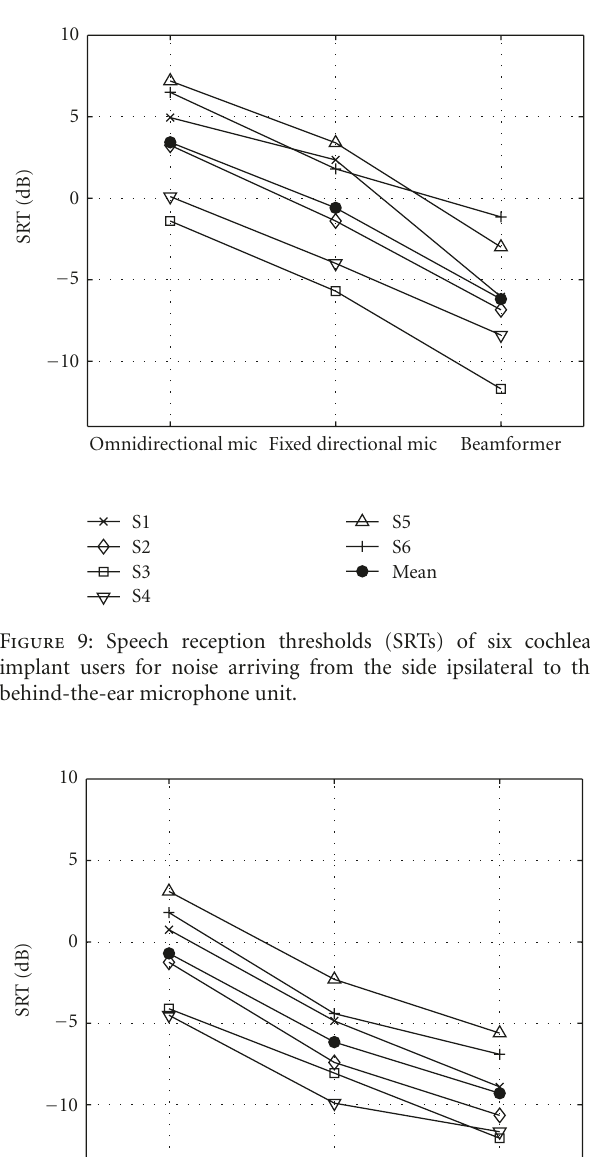
Figure 8: Speech reception thresholds (SRTs) of six cochlear implant users for target and noise signals arriving from the front.